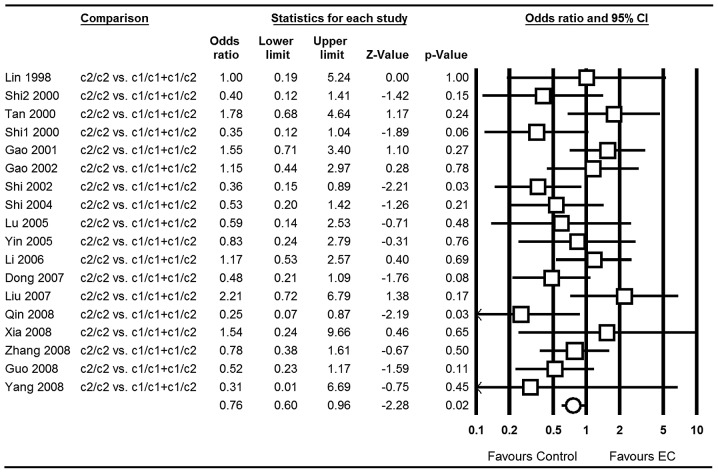
Forest plot of EC associated with CYP2E1 RsaI/PstI for the c2/c2 genotype compared with the c1/c1+c1/c2 genotype in total. CI, confidence interval; EC, esophageal cancer.